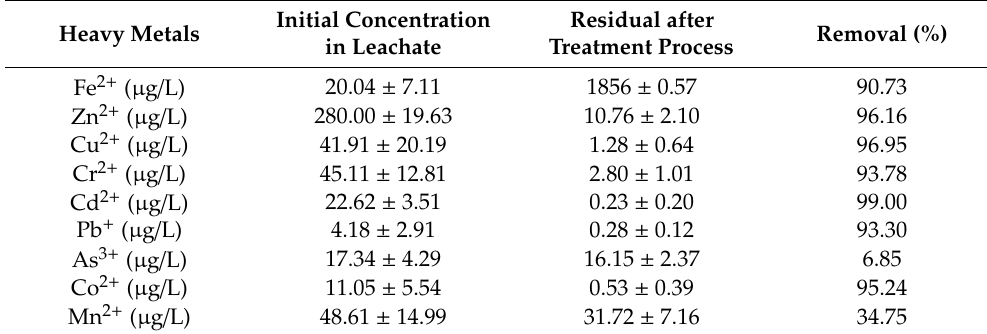
Table 6. E ff ect of the POME dosage and aeration time on heavy metal removal (POME dosage 188.32, aeration time 21